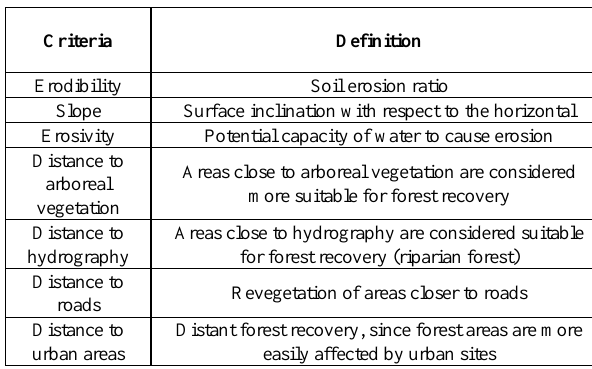
Table 1. Criterias definition to designed reforestation scenarios